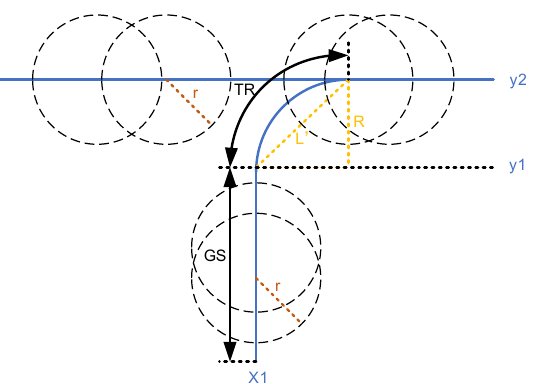
Figure 4. Vehicle trajectory in confluence condition based on vehicle body circular method.